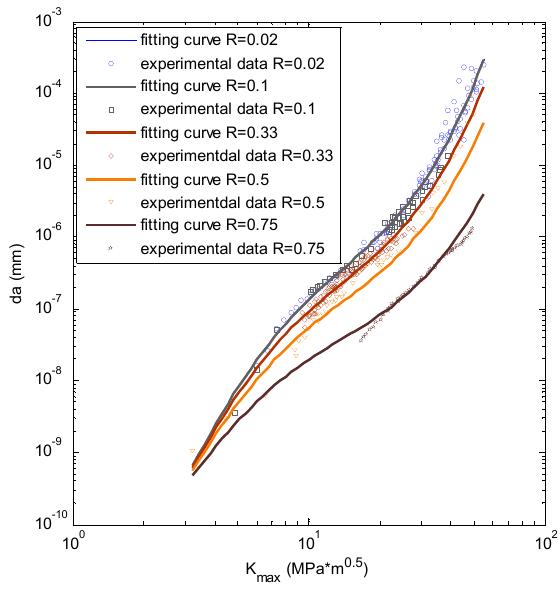
Figure 7. The fitting by ANN vs. the testing data for Al7075-T6.